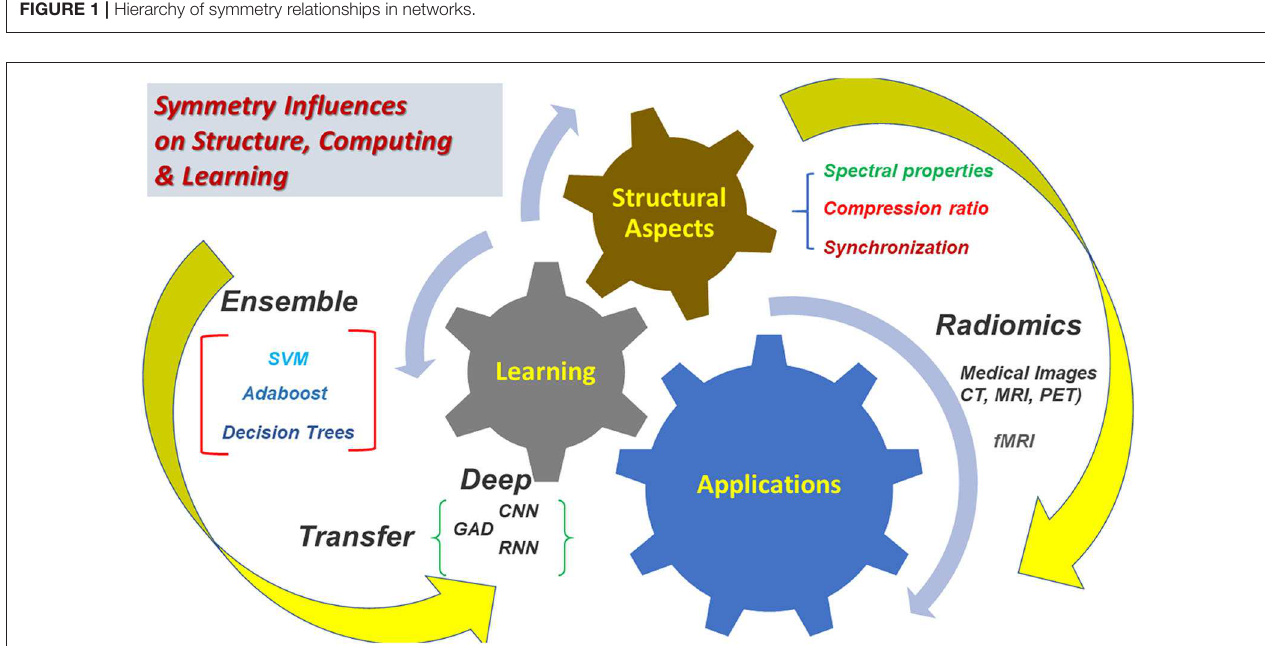
FIGURE 2 | Symmetry